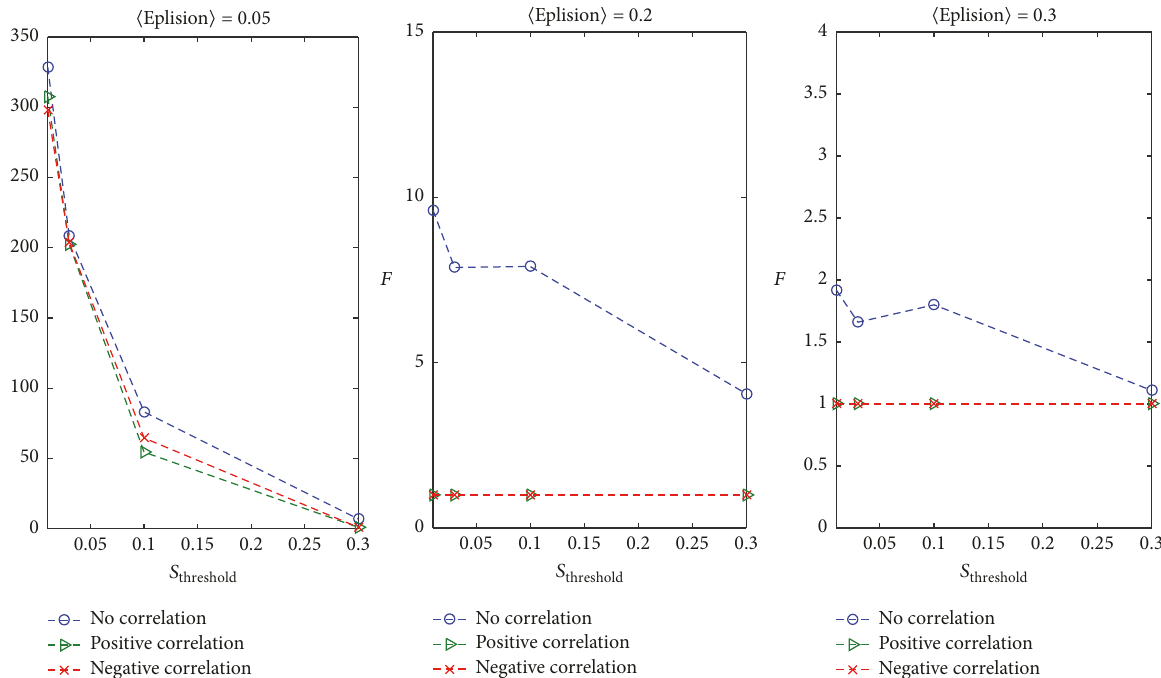
Figure 7: Comparison of 𝐹 (opinion cluster number) on the SSHK model under three correlation types of confidence bound and social similarity threshold, wherein 𝛼 = 3 . Every result is averaged 100 times.